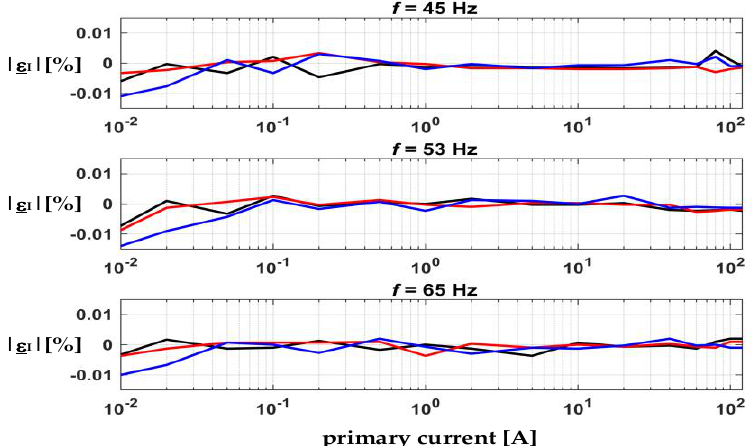
sequently, the measurement, with current channels attached as mentioned above, was re- peated at the same measuring points. The results obtained by considering the calibration data are shown in Figure 12. ε Figure 11. EECT prototype during H dist measurement. Measuring set-up for  ε I  (behind EECT). Figure 11. EECT prototype during H I | (behind EECT). dist measurement. Measuring set-up for |